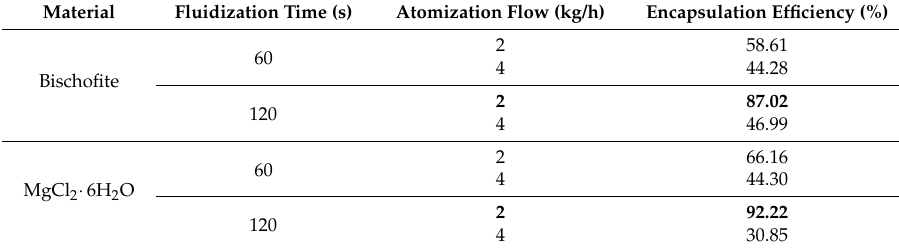
Table 6. Encapsulation